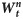
Time-points, flip angle pattern and soft-weights.a) Gridding reconstruction used in zero-filled MRF at different time-points in the acquisition, with 8 spokes per time-point. b) MRF-SOHO reconstruction at different time-points in the acquisition. High quality images are reconstructed at each time point with MRF-SOHO without affecting image contrast. c) Flip angle pattern used presents a smooth evolution. Coloured time-points correspond to the images above. d) Soft-weights (Wtn) for different neighbouring time-points (n) as a function of k-space radial distance (kr). The further away the time point, the less low frequency data is shared.